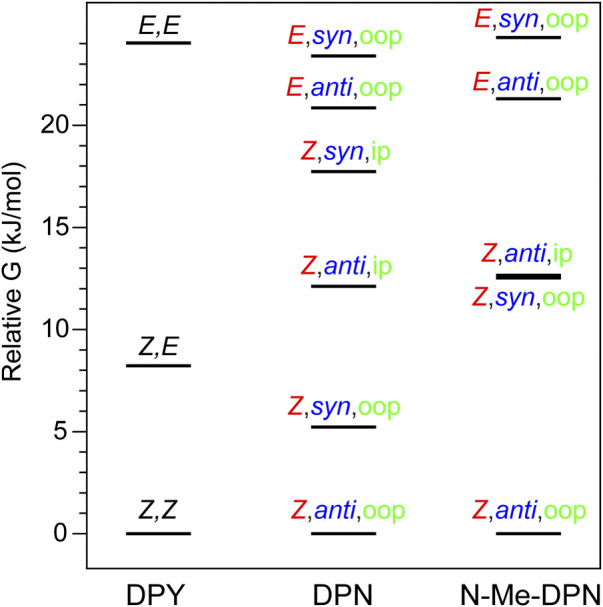
Gibbs free energy diagram for DPY, DPN, and N-Me-DPN conformational families.